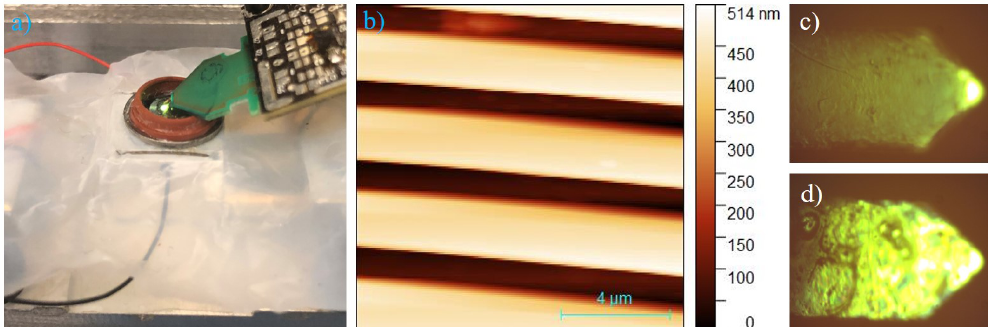
Figure 6. Acid imaging ( a ) sample in vinegar on the teflon sheet protected scanner, ( b ) tapping mode imaging of calibration grating with Z = 520 ± 3 nm step height and 3 ± 0.01 µ m pitch period from Ted Pella Inc with 12 micron by 12 micron range at 2 lines per second, ( c ) microscope image of coated active probe before experiment and ( d ) microscope image of probe after long time operation demonstrated partial coating detachment (probe is still functional and coating does not react with